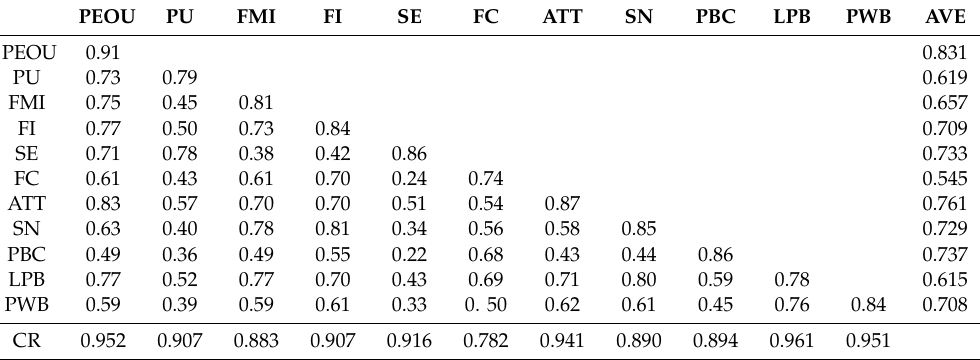
Table 2. Measure of correlations, reliability coe ffi cients, and average variance extracted (AVE).